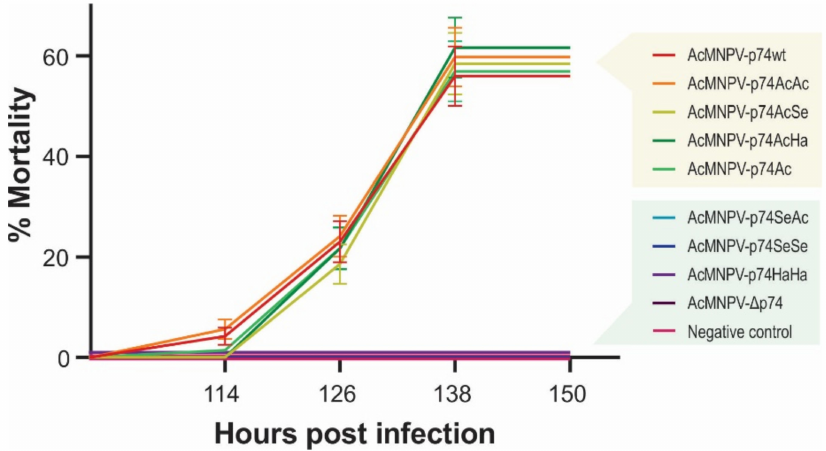
Figure 7. Virulence of the recombinant AcMNPVs in S. exigua . Mortality percentages of third-instar larvae of S. exigua orally infected by the droplet feeding method with the different variants of OBs (1 × 10 7 OBs/mL). Bioassay results (48 larvae in experimental units of 16 individuals for each treatment) are shown, and standard deviations are included. Exposed insects were maintained at 26 ◦ C, and mortality was recorded every 12